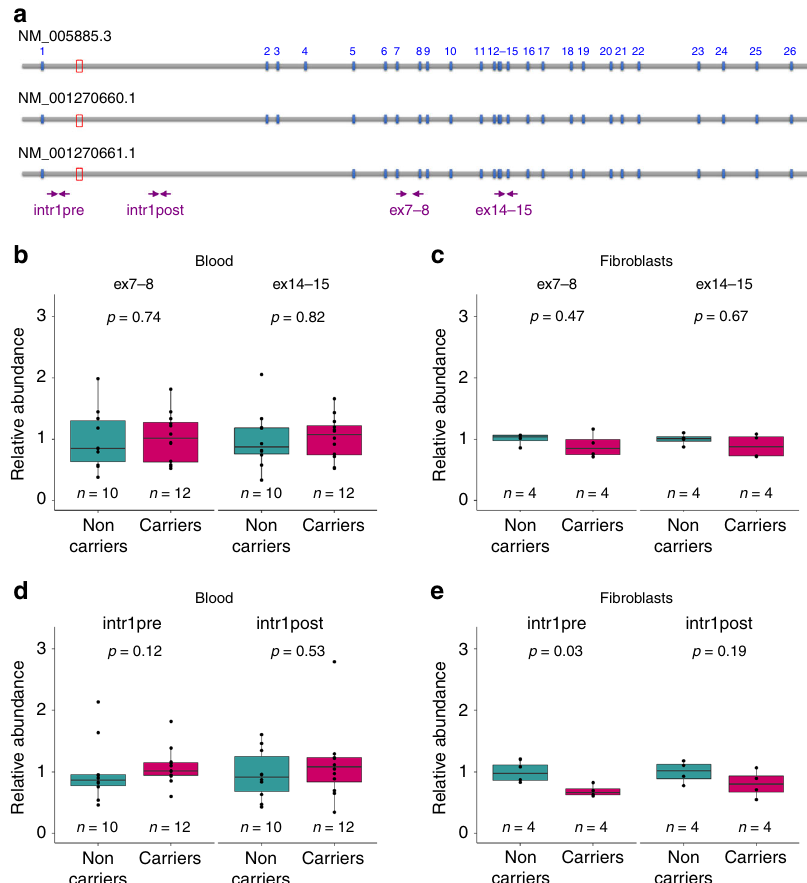
Fig. 6 Expansions do not affect MARCH6 expression in blood or skin. a Schematic representation of the MARCH6 transcript isoforms. The site of the expansion is indicated by the red box. Arrows indicate primer pairs used to quantify MARCH6 gene expression. b Results of real-time RT-PCR in blood from expansion carrier ( n = 12) versus healthy ( n = 10) individuals with primers speci fi c of exons 7 – 8 (left) and exons 14 – 15 (right). c Results of real-time RT- PCR in fi broblasts from expansion carrier ( n = 4) versus unrelated control ( n = 4) individuals with primers speci fi c of exons 7 – 8 (left) and exons 14 – 15 (right). d Results of real-time RT-PCR in blood from expansion carrier ( n = 12) versus healthy ( n = 10) individuals with primers located in intron 1 before (left) or after (right) the expansion. e Results of real-time RT-PCR in fi broblasts from expansion carrier ( n = 4) versus unrelated control ( n = 4) individuals with primers located in intron 1 before (left) or after (right) the expansion. Box plots elements are de fi ned as follows: center line: median; box limits: upper and lower quartiles; whiskers: 1.5× interquartile range; all values are displayed as points; outliers are shown as disconnected points. Statistical comparisons were done using a Wilcoxon – Mann – Whitney rank-sum test